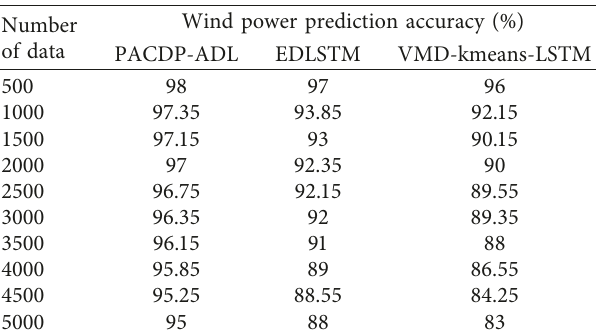
Table 1: Wind power prediction accuracy versus the number of data.